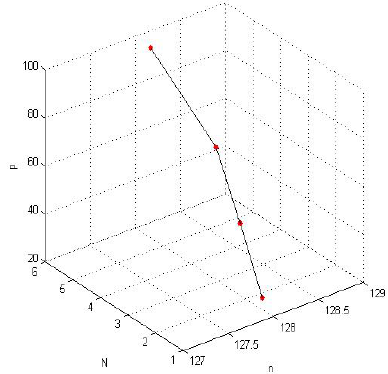
Figure 6 – A 3D graphic presentation for the password length of n = 160 bits Рис . 6 – 3 Д графическое изображение пароля размером n = 160 битов